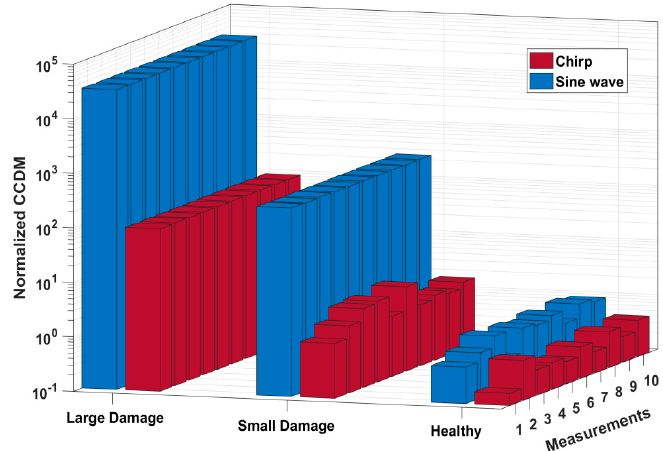
Figure 3. CCDM indices for both methods for the healthy condition and large and small